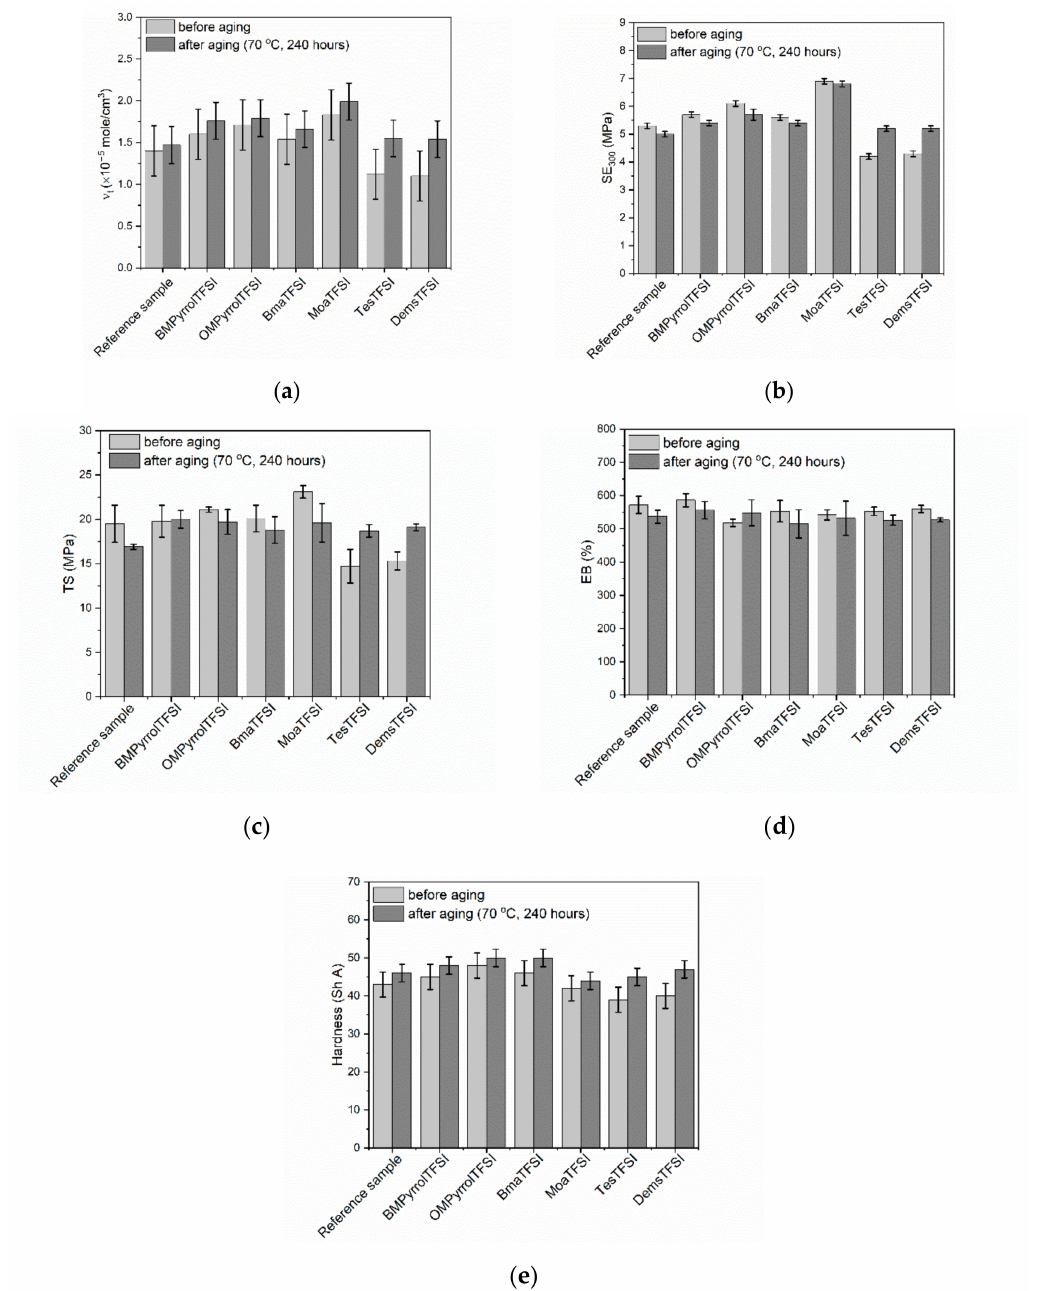
Figure 5. Influence of thermo-oxidative aging on the properties of NR vulcanizates containing ILs with TFSI anion: ( a ) crosslink density; ( b ) stress at 300% relative elongation; ( c ) tensile strength; ( d ) elongation at break; ( e )